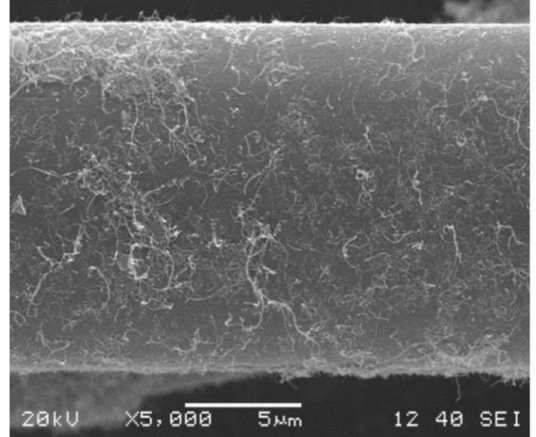
Figure 6. p-phenylene terephthalamide (PPTA) fiber with carbon nanotubes (CNTs) attached on to the surface [61]. Reprinted with permission from ref. [61]. Copyright 2016